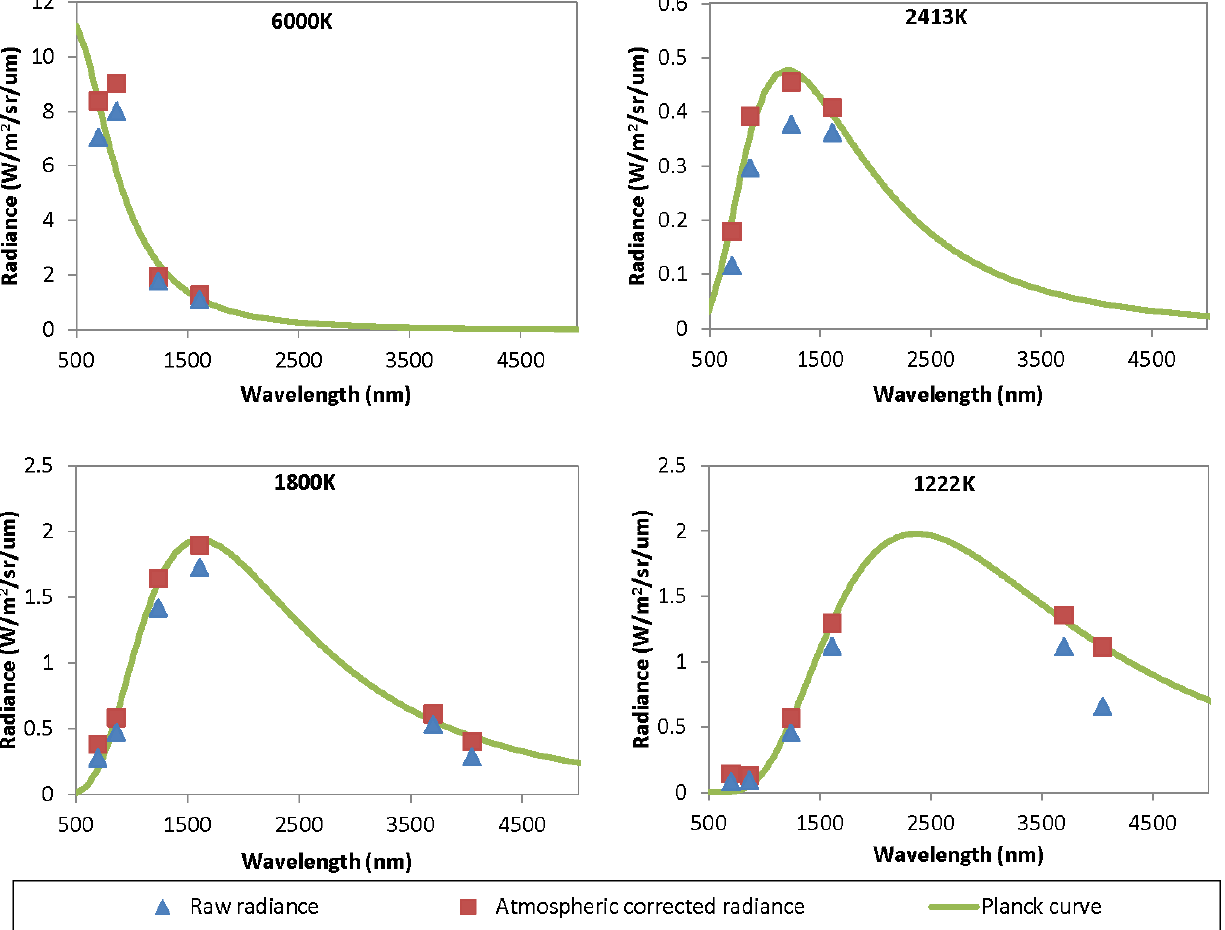
Figure 19. Nightfire Planck curve fits spanning 600 to 6,000 degrees K. The 6,000 K curve is from the Luxor sky